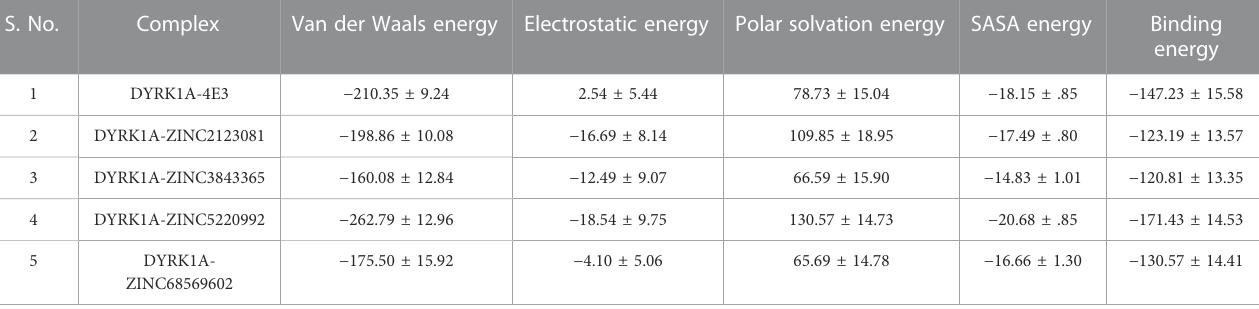
TABLE 3 Table represents van der Waals, electrostatic, polar solvation, SASA, and binding energies in kJ.mol − 1 for the control compound (4E3) and predicted hits. S.